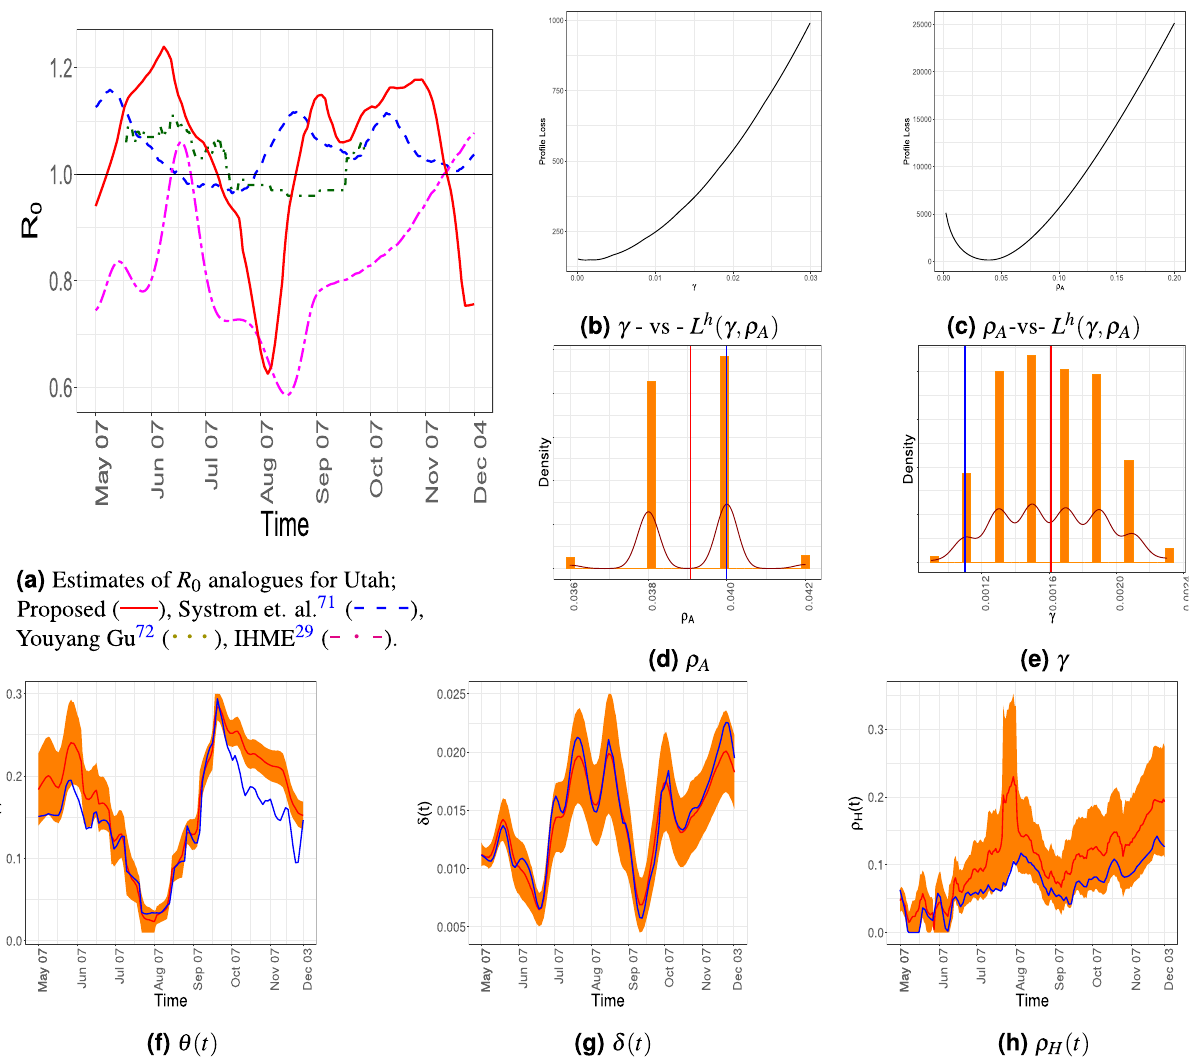
Figure 3. ( a ) Estimates of R 0 analogues. ( b – c ) Estimates and residual bootstrap based confidence intervals for time invariant and time-varying parameters for the state of Utah. The estimate from the data is in blue. The 95% confidence band is in yellow and the mean of the bootstrap estimates are presented in